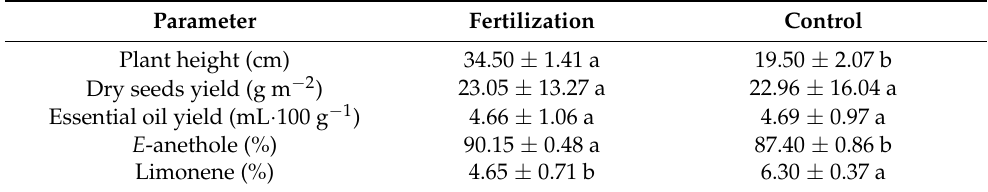
Table 8. Effects of fertilization (across shading treatments) on growth parameters and essential oil main components (mean ± SD) of